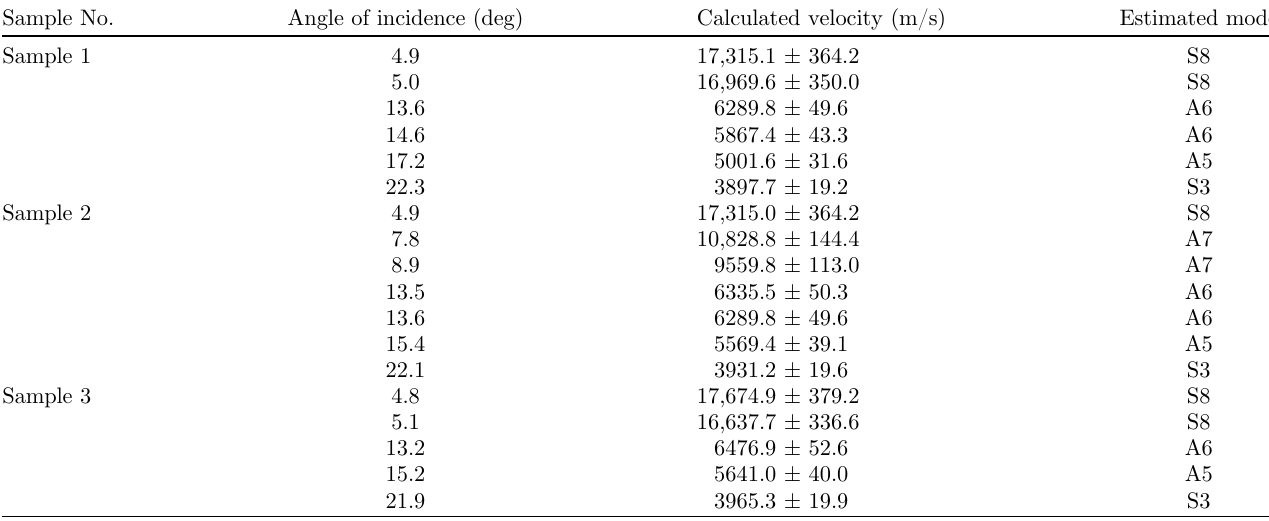
Table 2. Identi fi ed modes based on phase velocity at the Schoch effect angle of incidence, compared with dispersion curves. Sample No. Angle of incidence